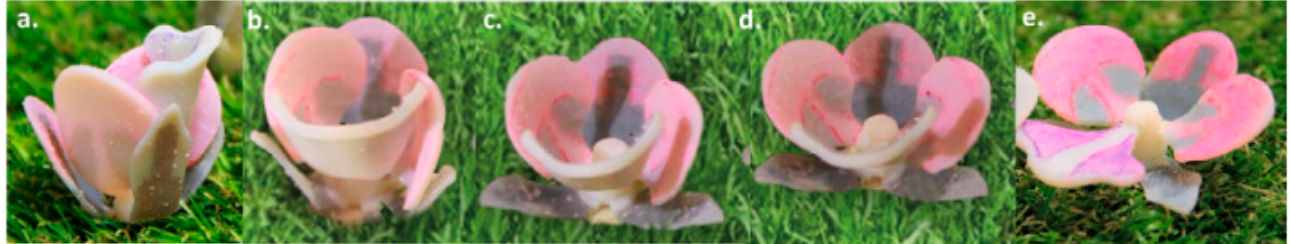
Figure 31. 4D printing of smart material (adapted with permission from reference [142]).